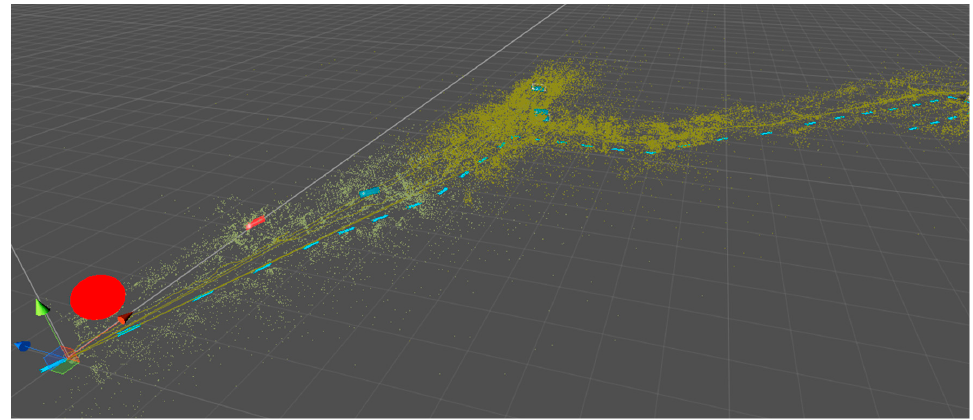
Figure 5. Visualization of mapped point features of a region covering a distance of 150 meters. The red point correlates to the starting position of the mapping process, whereas the blue dashed line shows the path to a target area.